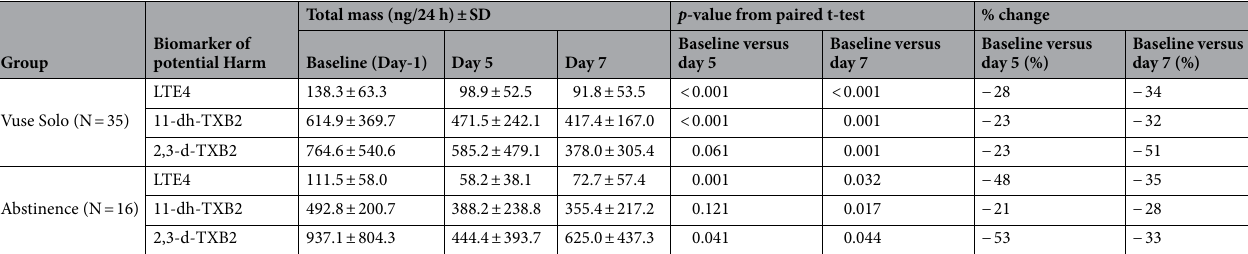
Table 1. Urinary levels of LTE4, 11-dh-TXB2, and 2,3-d-TXB2 in smokers switched to Vuse Solo or Abstinence for 5 and 7 days. LTE4 leukotriene E4, 11-dh-TXB2 11-dehydro-thromboxane B2, 2,3-d-TXB2 2,3- dinor thromboxane B2, SD standard deviation.